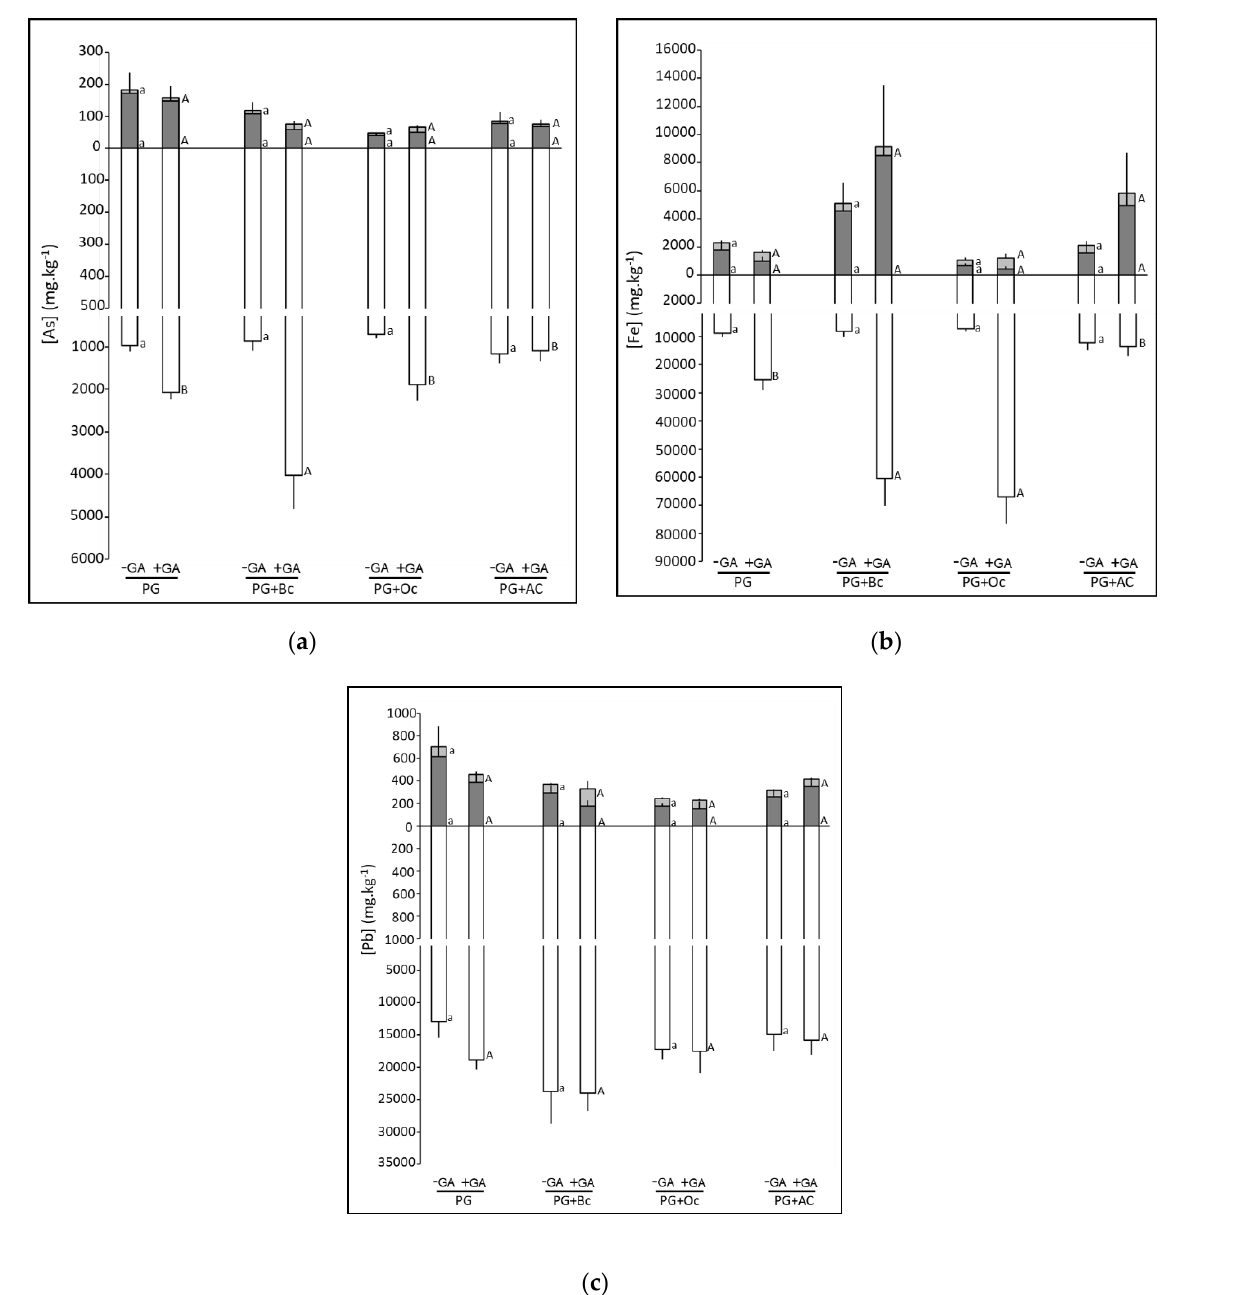
Figure 3. Leaf (light grey), stem (dark grey) and root (white) arsenic ( a ), iron ( b ), and lead ( c ) concentrations (mg.kg − 1 ) of Populus × . canescens after 45 days of growth on Pontgibaud technosol alone (PG) or amended with biochar (PG+Bc), ochre (PG+Oc) and activated carbon (PG+AC), associated or not with green amendment (+/ − GA). Small letters indicate a significant difference between the treatments without green amendment while capital letters indicate a significant difference between the conditions with the green amendment (p < 0.05) (n = 5 ± SE).